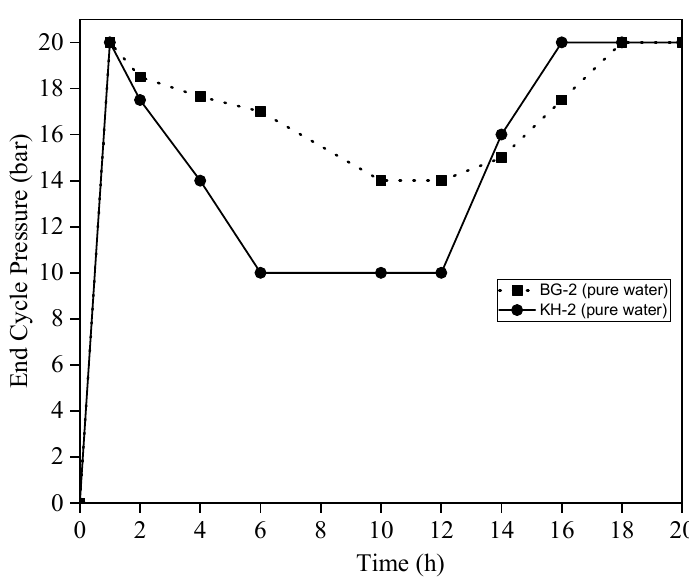
Figure 11. The end cycle adsorption pressure for BG-2 and KH-2 shales treated with pure water. The adsorption behavior of the two shales “BG-2 and KH-2” after treatment with IOS is shown in Figure 12, where the end-cycle pressure is plotted vs. time. A reduction in pressure was noted in KH-2 shale (solid curve) up to the end of the 3rd cycle (a 30% reduction in pressure). However, it was not as significant as with the purely distilled water case cycle (was a 50% reduction in pressure). Less significant reduction in end-cycle pressure was seen in BG-2 shale, where only a 10% reduction in pressure was noted at the end of the 2nd cycle. When comparing the end cycle pressure reading in both shales, it is found that KH-2 showed higher CH4 adsorption than BG-2, as was the case with pure water treatment. Energies 2018 , 11 , x